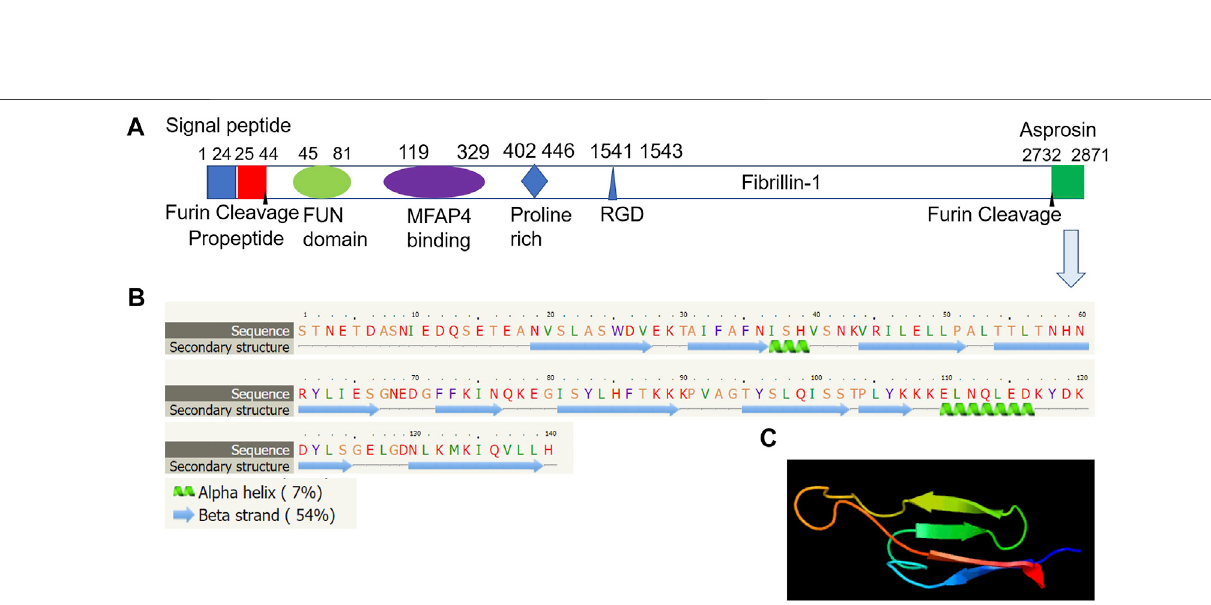
Frontiers in Physiology |